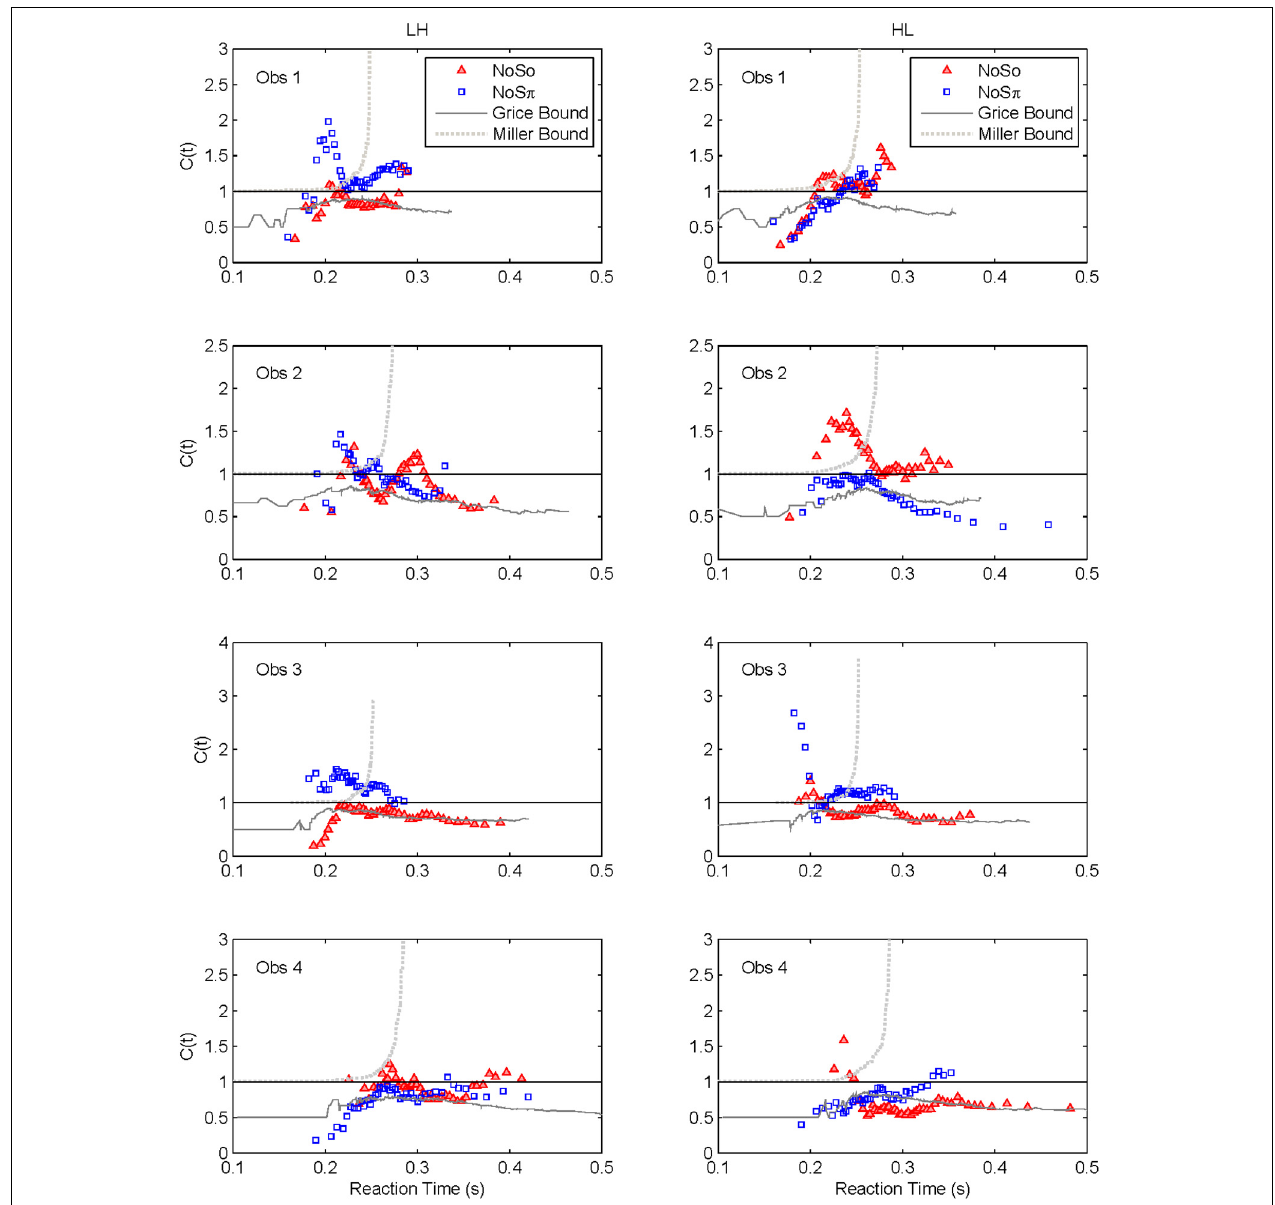
FIGURE 9 | Capacity functions for the two contexts are shown for LH and HL